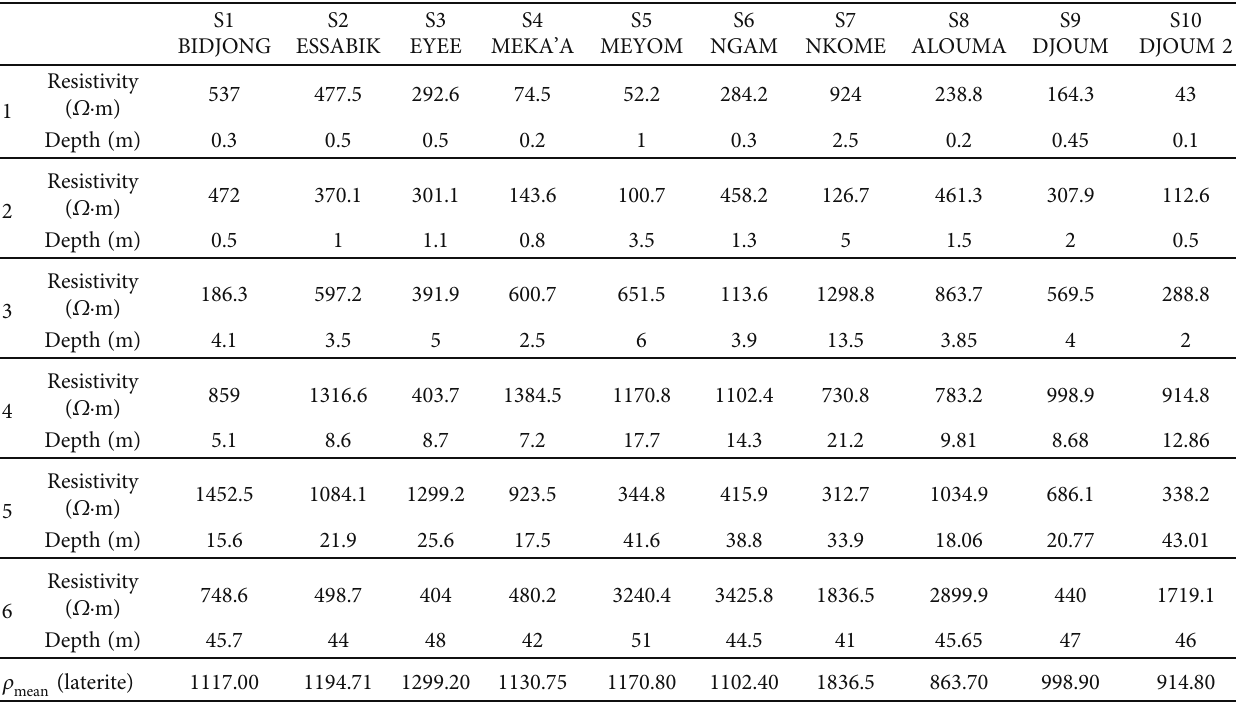
Table 4: Compiled VES data in the plutonic